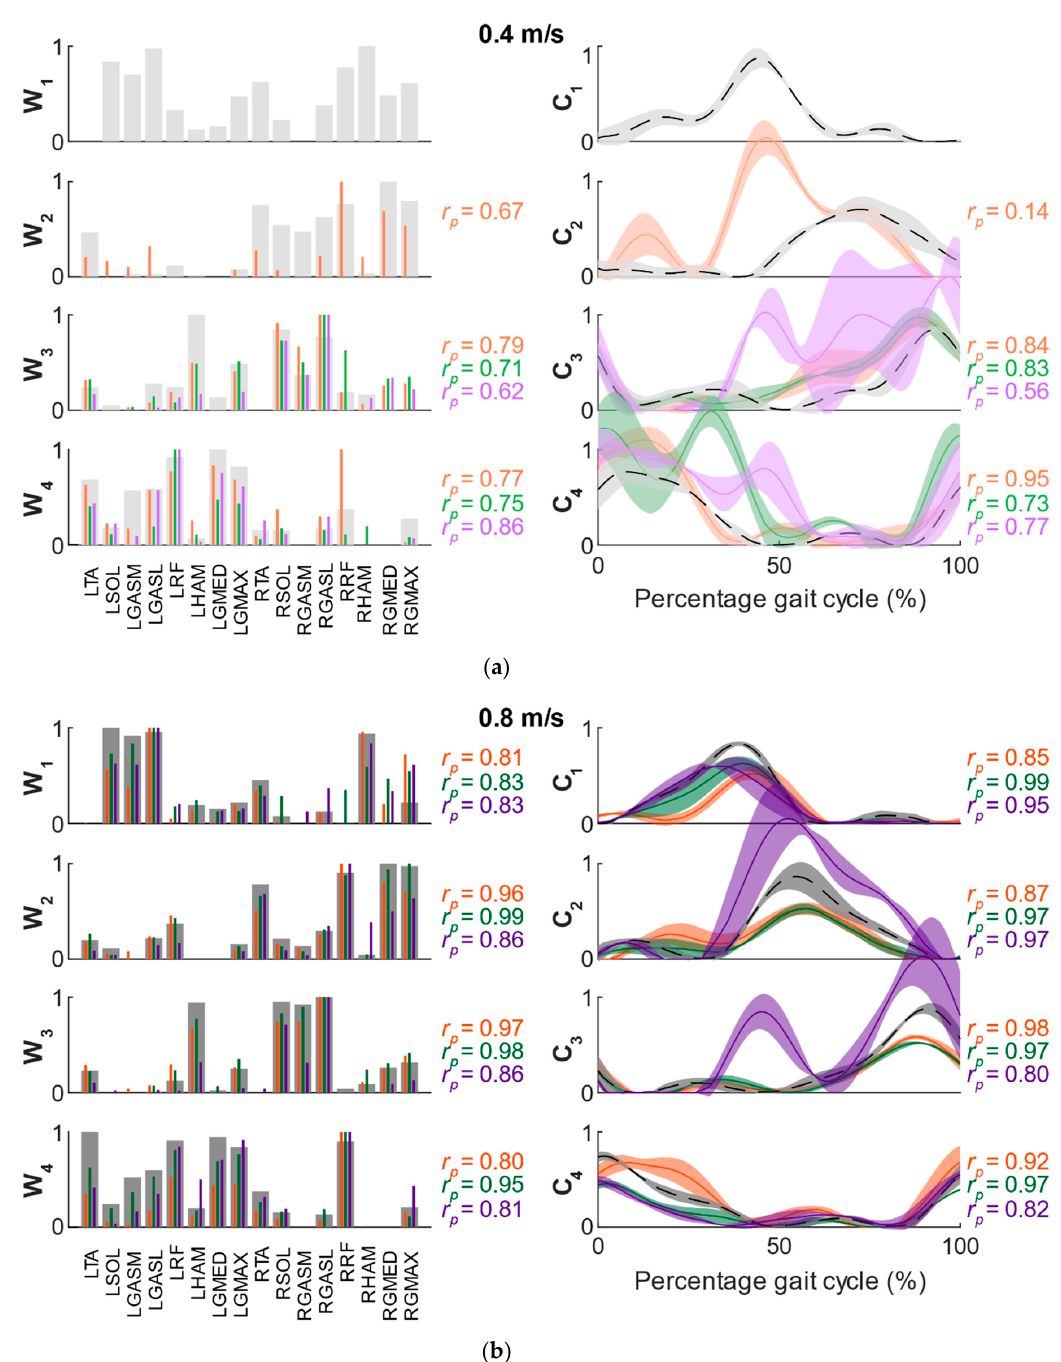
Figure 6. Muscle synergies and weighting curves for inward-directed perturbed walking and unperturbed walking at ( a ) the lowest and ( b ) the fastest walking speed for a representative subject. The colors indicate unperturbed walking (grey) and perturbed walking, with a perturbation onset of 0% (orange), 30% (green), or 60% (purple) of the stance phase of the gait cycle. ( left ) Muscle synergies for unperturbed (wide grey bars) and inward-directed perturbed walking for different perturbation onsets (narrow colored bars). Muscle synergies for perturbed walking were only shown when simi- lar to the corresponding muscle synergy for unperturbed walking ( r p ≥ 0.623). ( right ) Weighting curves for unperturbed (black striped line) and perturbed walking with different perturbation onsets (colored solid lines). Weighting curves are displayed as the mean value (lines) ± standard deviation (shaded area) of three